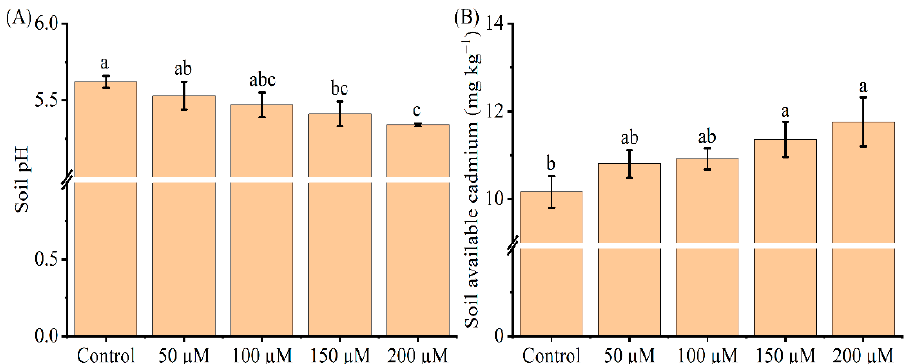
Figure 6. Effect of exogenous melatonin application on the soil pH ( A ) and available Cd ( B ) content. The data represent means ± standard deviations for three replicates. Different letters indicate groups that are significantly different at p < 0.05.